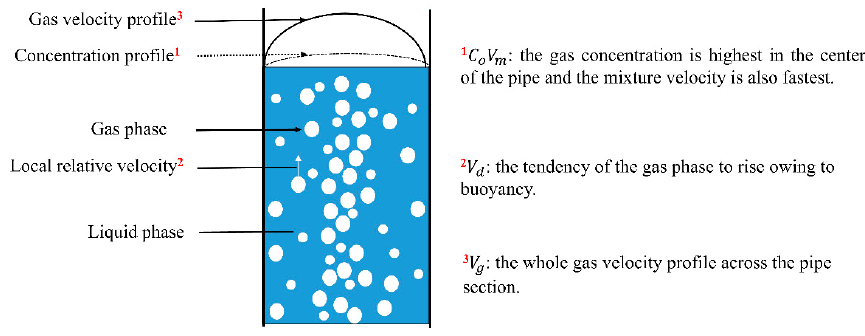
Figure 2. Schematic of DF models. This figure was modified from Figure 1 in ref [60]. DF models require some empirical parameters. However, most of these parameters must be determined by experiments in vertical pipes with 2 inches or smaller